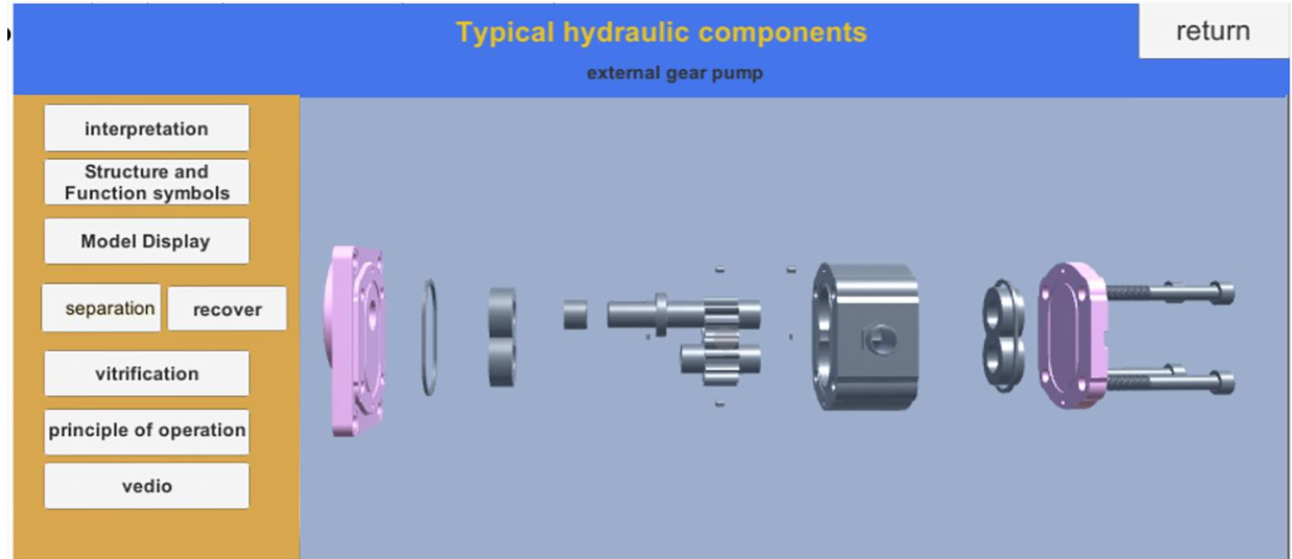
Figure 9. Automatic disassembly and assembly of the external gear pump.